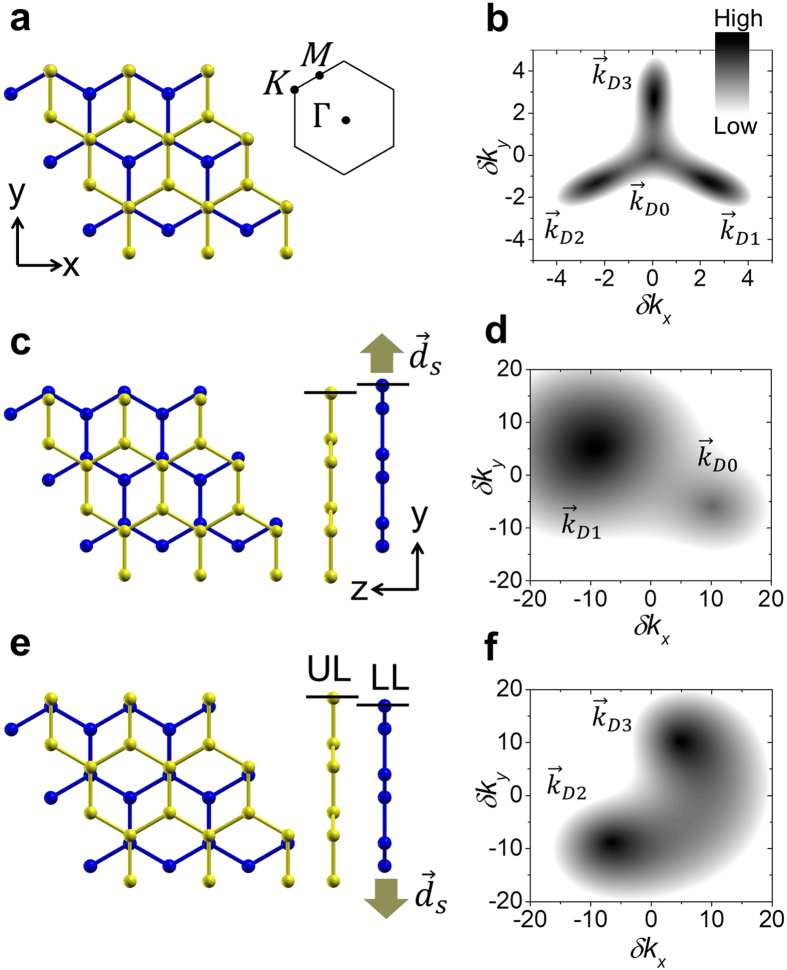
Atomic geometry and energy map for the valence band near the  point.(a) Atomic geometry of AB-stacked BLG. Blue and yellow spheres correspond to the carbon atoms in the lower and upper layers, respectively. Inset shows the first Brillouin zone and the symmetric points of ,  and . (b) Energy map for the valence band of AB-stacked BLG.  =  = 1000 in units of 2/ and high energy appears dark. The darkest spots (energy maxima) correspond to four Dirac cones at the Dirac points of , ,  and . Panels (c,d) show the atomic geometry and the energy map for the valence band of sliding BLG with ds = + 0.24 , respectively. Panels (e,f) show the atomic geometry and the energy map for the valence band of sliding BLG with  = −0.24 , respectively. In panels (c,e), The top and side views are shown on the left and right, respectively, and the arrows indicate the sliding direction of the lower layer (LL) with respect to the fixed upper layer (UL).